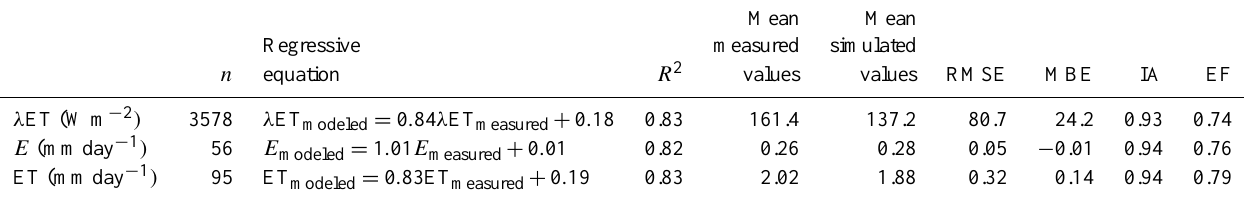
Table 2. Statistical analysis of measured and estimated, using the median parameter values, half-hourly evapotranspiration ( λ ET; Wm − 2 ) , daily soil evaporation ( E ; mmday − 1 ) , and daily evapotranspiration (ET; mmday − 1 ) for the spring maize in arid desert oases during the study period. Mean Mean Regressive measured simulated n equation R 2 values values RMSE MBE IA EF λ ET (Wm − 2 ) 3578 λ ET modeled = 0 . 84 λ ET measured + 0 . 18 0.83 ET modeled = 0 . 83ET measured + 0 . 19